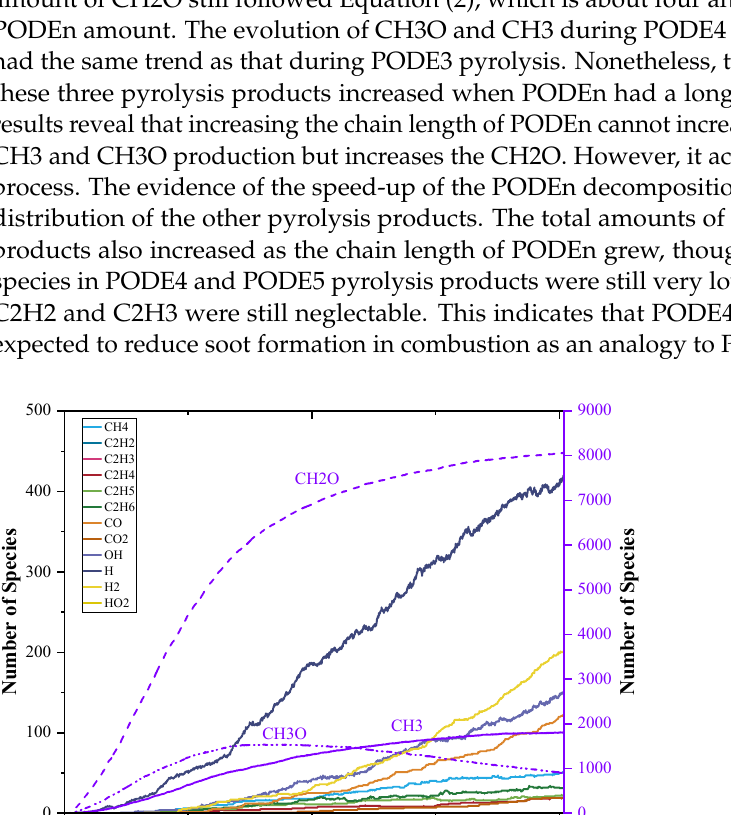
Figure 9. Time evolution of C0 ‐ C2 species during the simulation of PODE4 pyrolysis using ReaxFF MD.